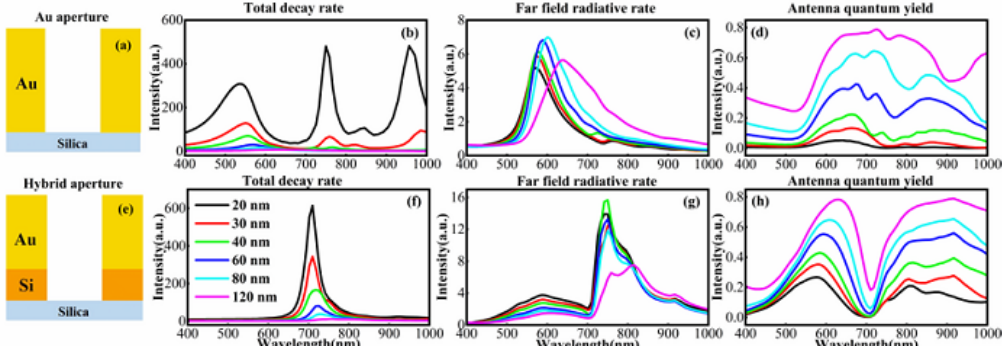
Figure 3. The enhancement effects are dependent on the aperture size of the antenna: ( b ) total decay rate enhancements; ( c ) far-field radiative rate enhancements; and ( d ) antenna quantum yields of ( a ) the Au nano-aperture antenna with diameters from 20 to 120 nm. Panels ( f – h ) show the same corresponding plots for ( e ) the Au/Si hybrid nano-aperture antenna with diameters from 20 to 120 nm, respectively. The thickness of the Au layer is 100 nm for gold aperture, and the hybrid structure consists of an 80 nm Au layer and a 20 nm Si